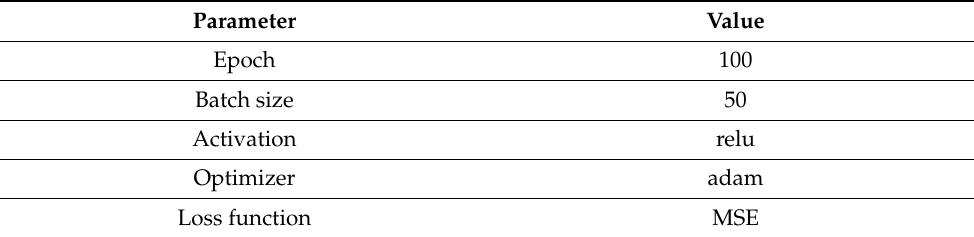
Table 7. Deep learning training